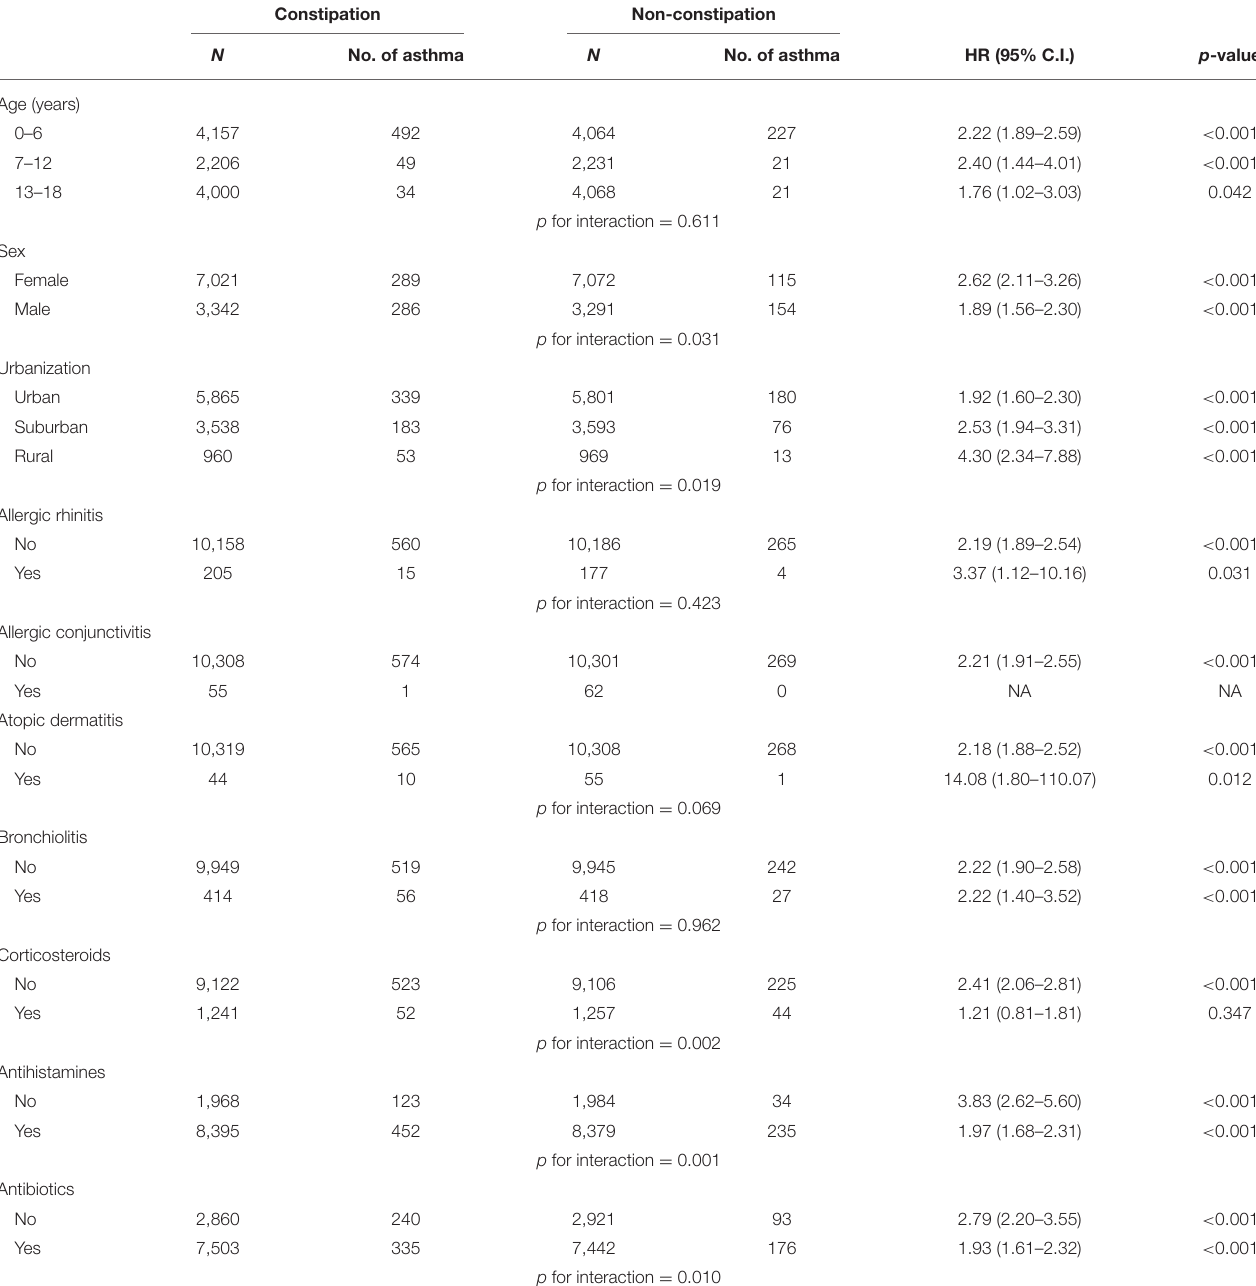
TABLE 3 | Subgroup analysis of the association between constipation and asthma development. Constipation Non-constipation No. of asthma N No. of